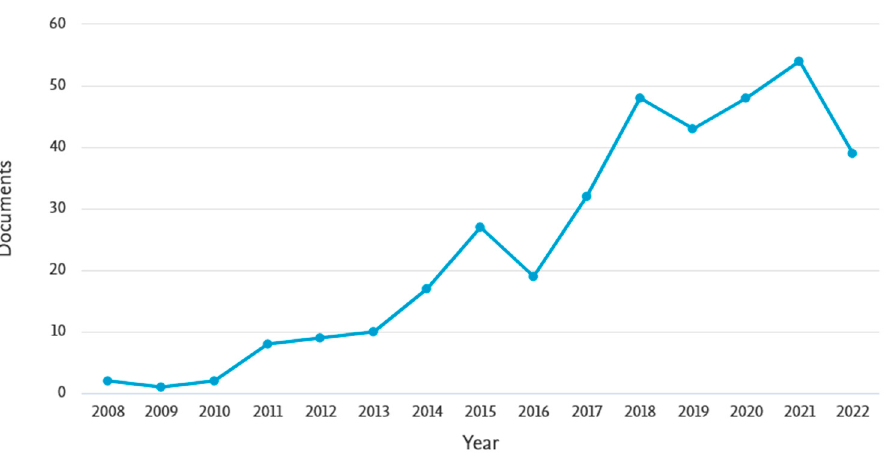
Figure 2. All published articles from 2008 to 2022 in an analyzed sample of 324 articles (2022 is not a full year).